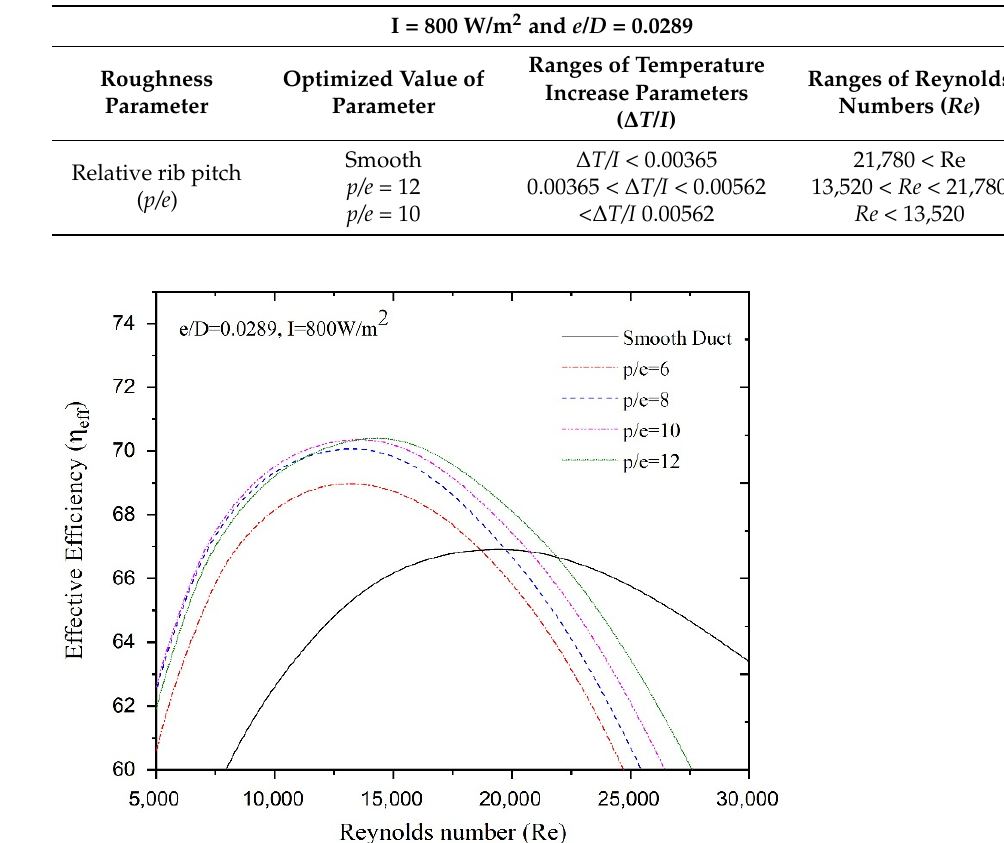
Figure 9. Effect of Reynolds number on effective efficiency. Table 4. Ranges of temperature increase parameters and Reynolds numbers.